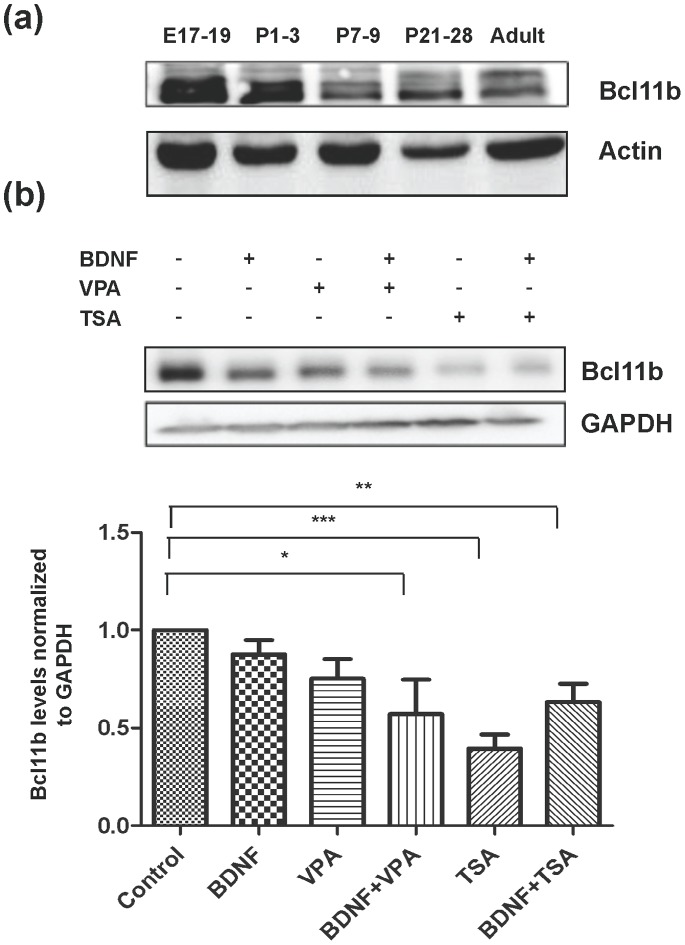
Bcl11b protein level is down-regulated in the presence of HDAC inhibitors.(a) Ontogeny of Bcl11b in striatum in Swiss-Webster mice. Bcl11b levels decrease markedly post-natally, particularly between the first and second week of life. (b) Primary striatal neurons were treated with VPA (3 mM) or TSA (10 nM) with or without BDNF (10 ng/ml) for 24 h. Similar results were observed after treatment with compound 4 b (not shown). N = 3–5; +/− SEM (*p<0.05, **p<0.01, ***p<0.001).